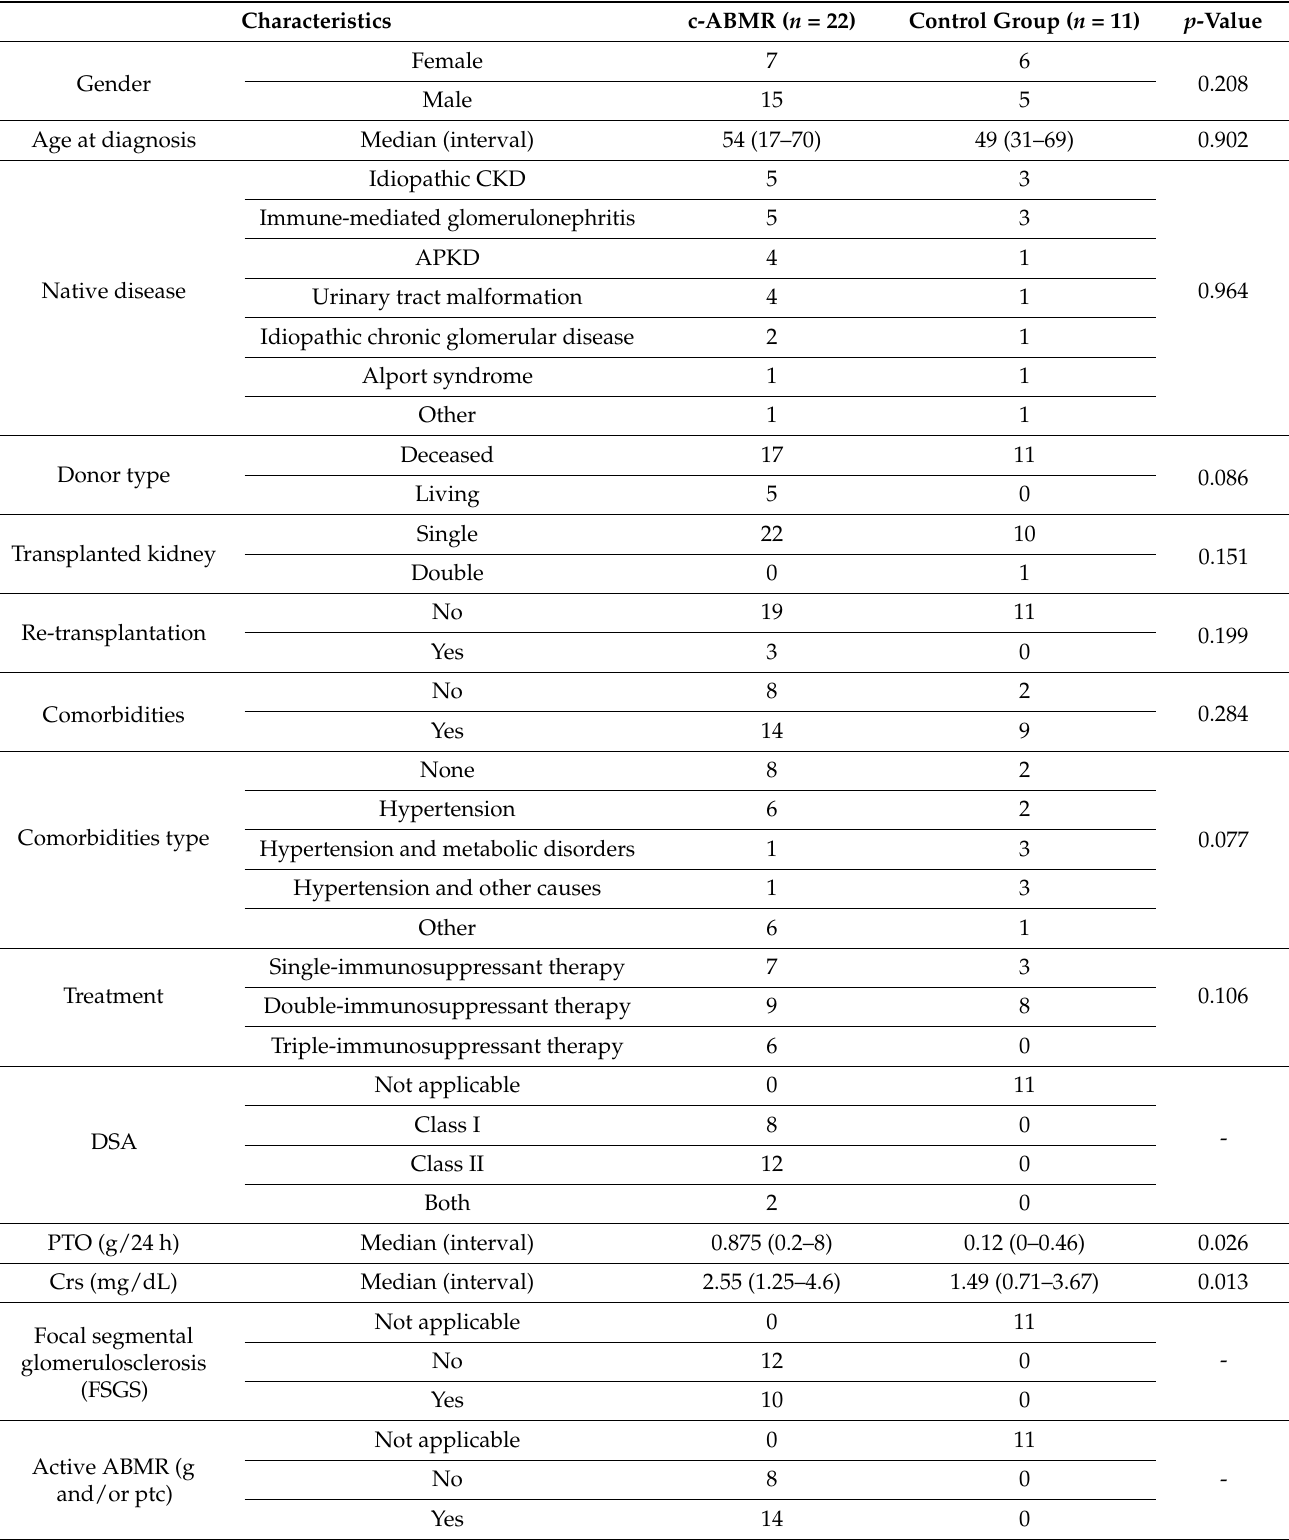
Table 2. Clinicopathological characteristics of c-ABMR cases compared with the control group. CKD: chronic kidney disease; APKD: polycystic kidney disease; PTO: proteinuria; Crs: creatininemia; g: glomerulitis; ptc: peritubular